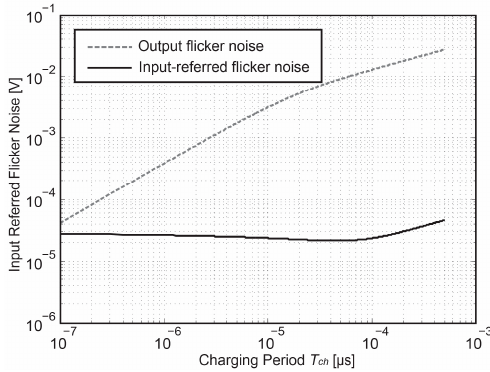
Figure 9. Input referred flicker noise as a function of charging period T ch.